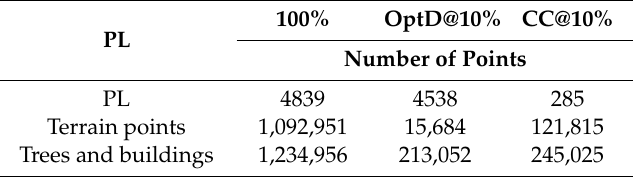
Table 7. E ff ect of data reduction on PL points.